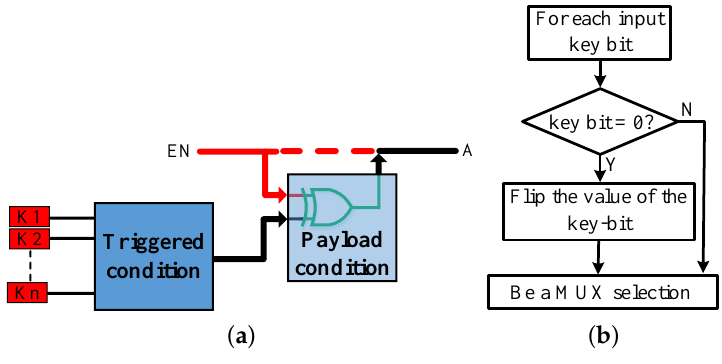
Figure 3. ( a ) Hardware logic unit (HLU) idea to protect the design. ( b ) Flip the key bit